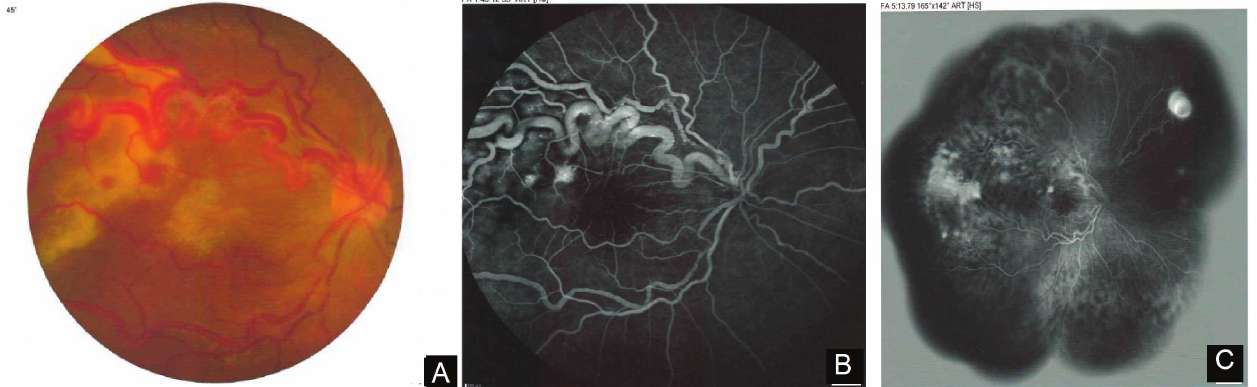
Figure 1. (A) Color fundus photograph of an exudative extrapapillary RCH. Note enlarged and tortuous feeding vessels passing toward a peripheral RCH, in addition to small RCHs in macula. (B) Wide field fundus angiogram. (C) Montage modality of angiography for more peripheral